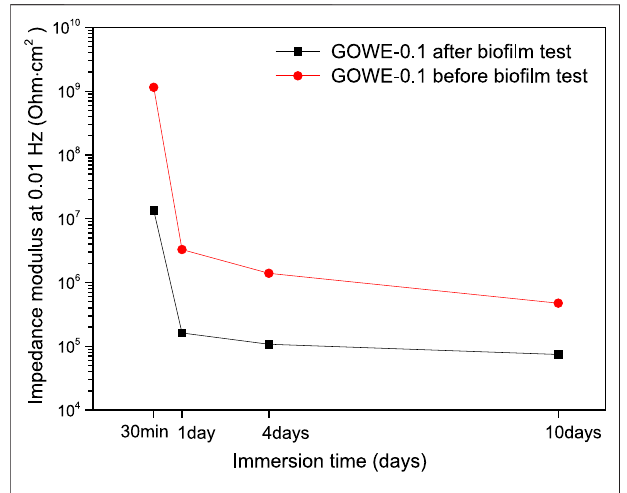
FIGURE 7 | Impedance modulus at 0.01 Hz as a function of the immersion time for GOWE-0.1 coatings with and without bio fi lm testing.